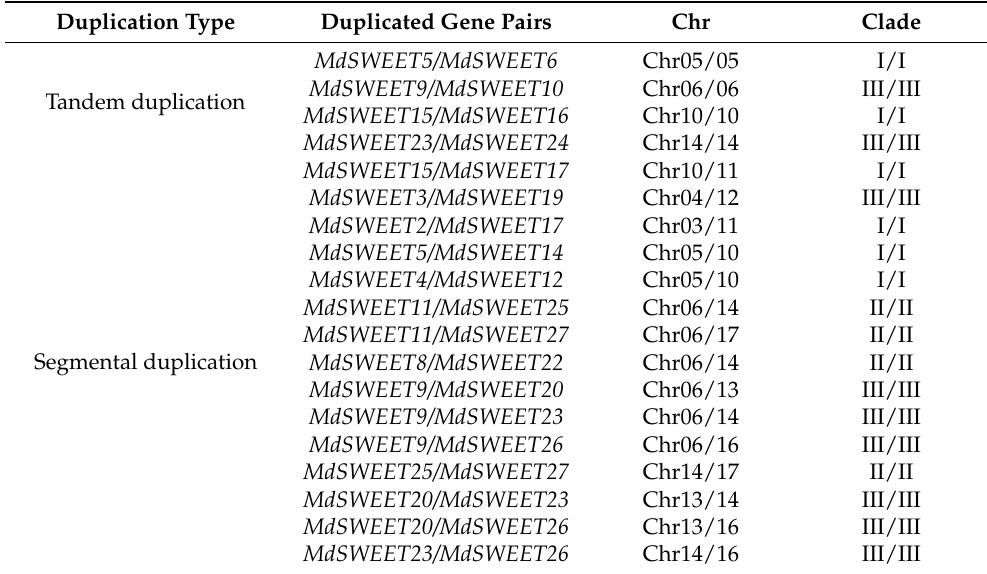
Figure 5. Chromosome localization of MdSWEET s. The bars indicate the apple chromosomes, and the chromosome numbers are shown at the left of each chromosome. The scale ruler on the left side shows the physical distance of the chromosomes. The relative positions of MdSWEETs are marked on the chromosomes. Table 3. Basic information of MdSWEET homologous genes. The duplication events were detected using the MCScanX software. Nineteen SWEET gene pairs were detected as duplicated gene pairs, of which four were tandem duplications and fifteen were segmental duplications.